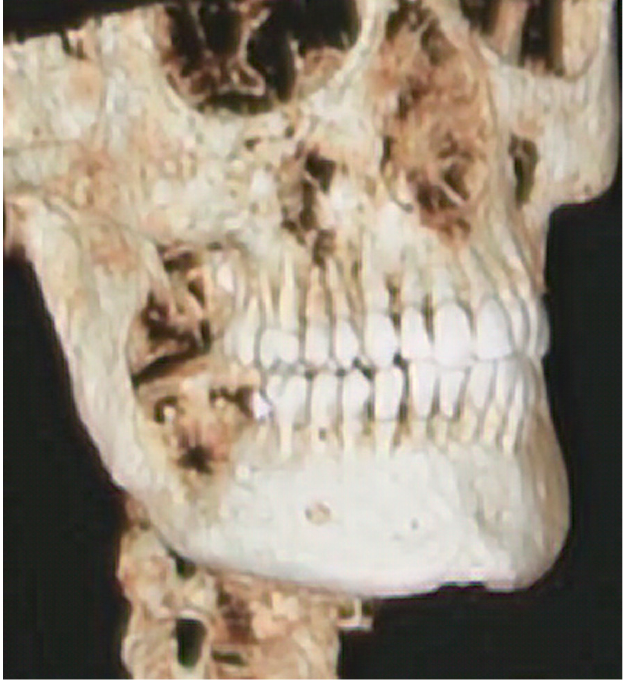
Figure 10. CT scan 3D reconstruction showing the ameloblastoma lesion involving the body and ramus of the right mandible.